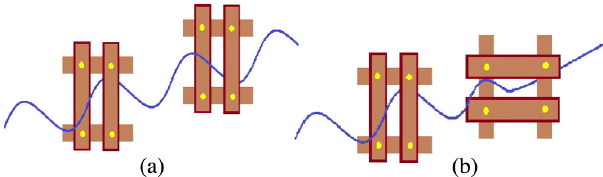
FIG. 2. Mechanical analogy of polarization of light with an oscillating rope passing through two